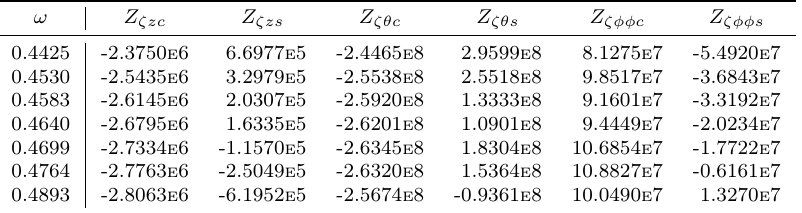
Table 13: Restoring force heave (wave)